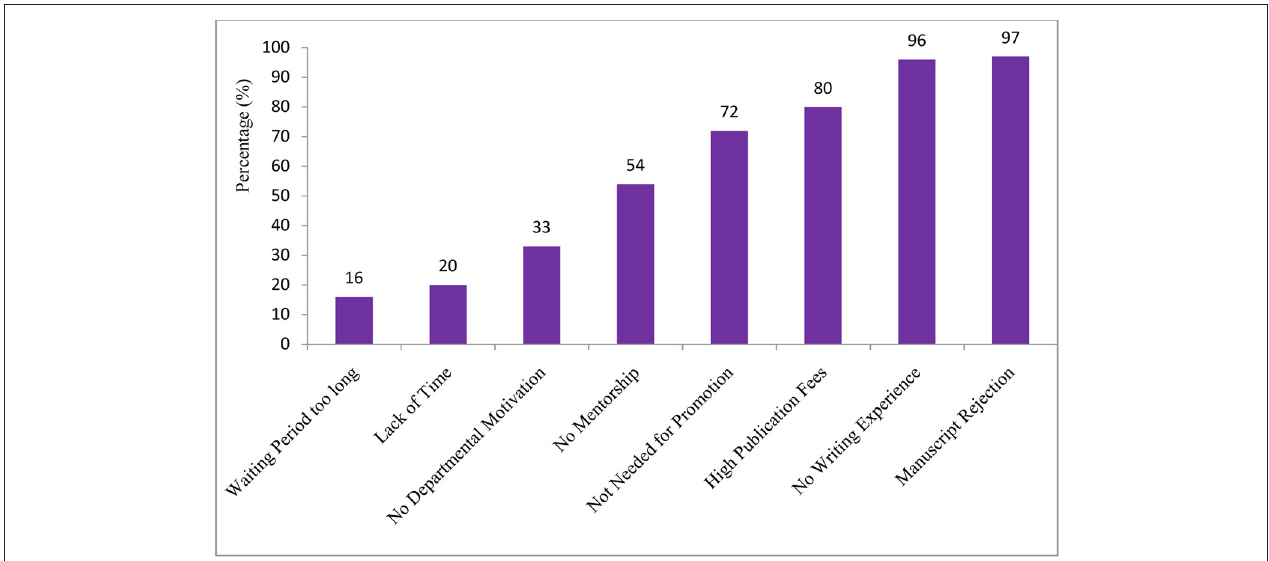
FIGURE 3 | Reasons for not publishing by participants without published article. NB, Values presented are in percentages.